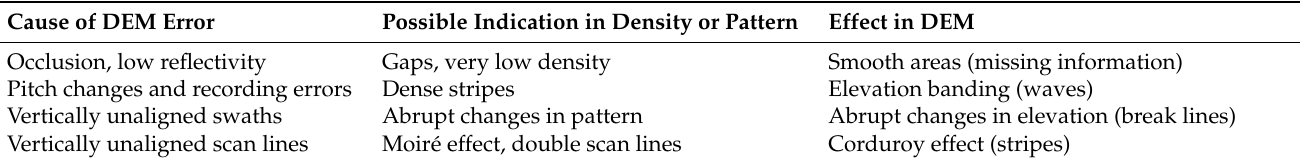
Table 3. Errors in interpolated DEM, their relations to density, and their